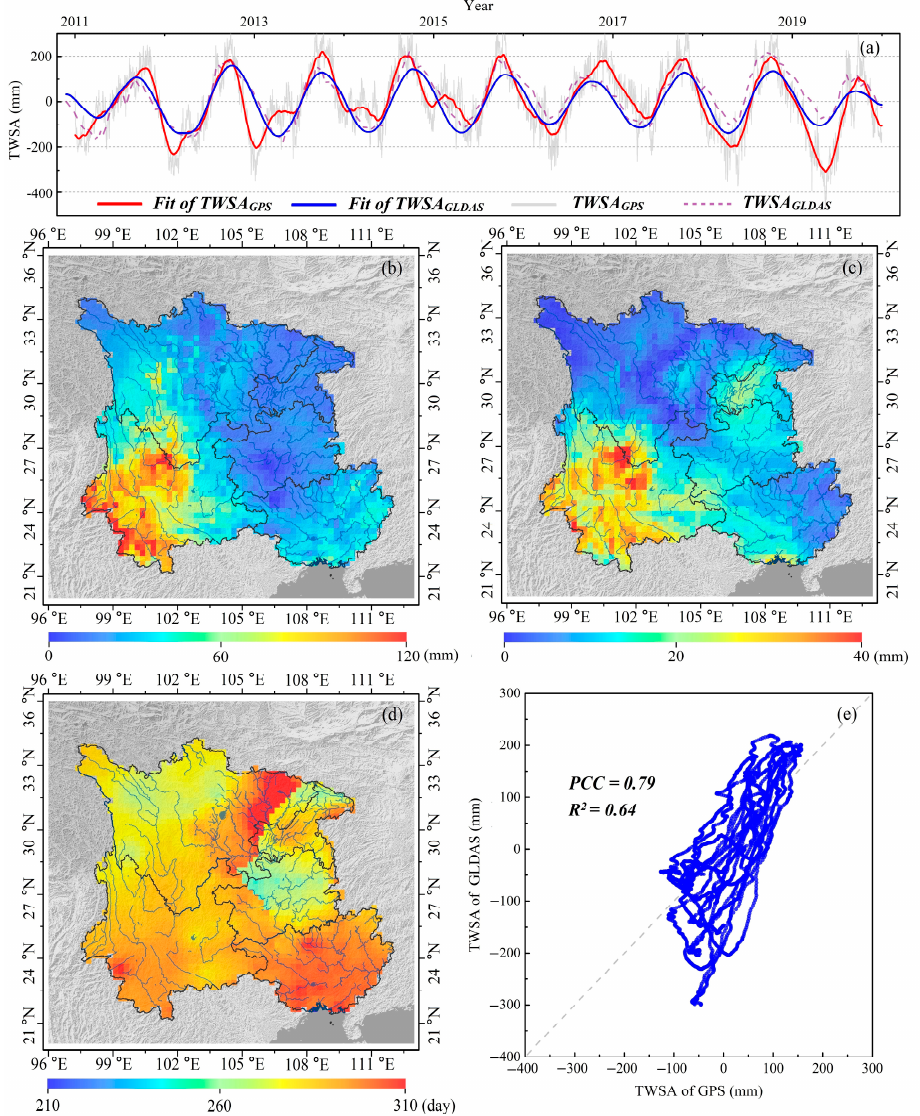
Figure 10. The compared result of GLDAS solutions, showing in the average fitting sequence ( a ), annual ( b ), semi-annual ( c ) and periodic items ( d ) of GLDAS, and scatter figure ( e ).